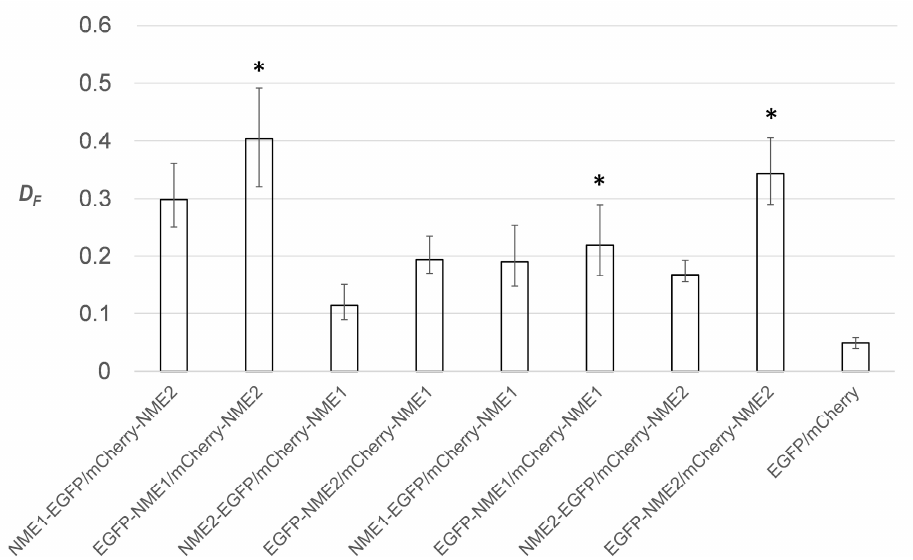
Figure 3. Fractional FRET population ( D F ) for di ff erent combinations of fluorescently labeled NME proteins: NME1 / NME2, NME1 / NME1, and NME2 / NME2 (see main text for explanation). Donor molecule (EGFP) was fused either to the N-terminus or the C-terminus of an NME protein, while the acceptor molecule (mCherry) was always fused to the N-terminus of an NME protein. D F is shown as the median and the interquartile range. The star sign (*) indicates the highest D F for each of the three combinations of NME proteins.